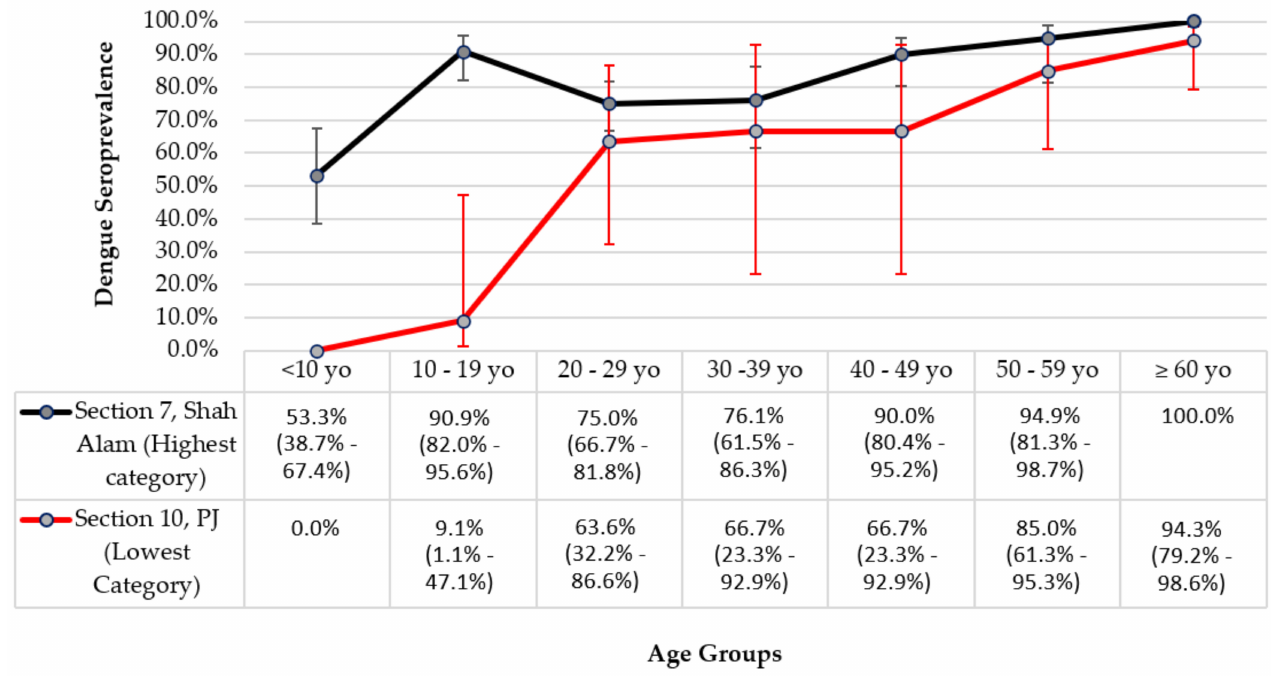
Figure 2. Age-specific dengue seroprevalence with 95% confidence interval by incidence